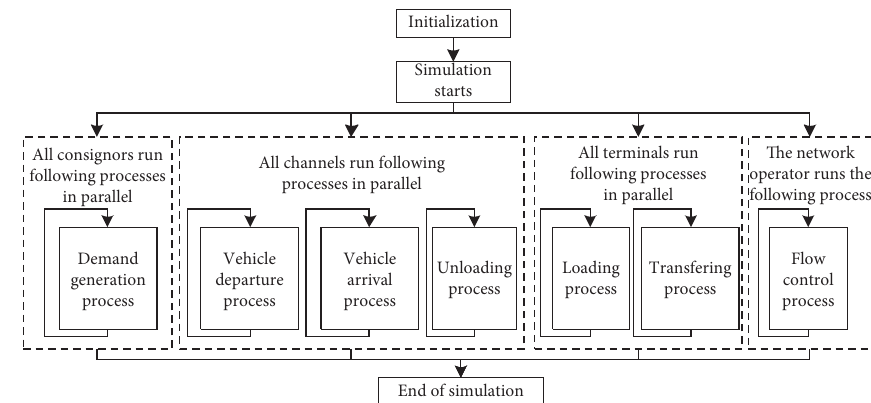
Figure 5: Block diagram of